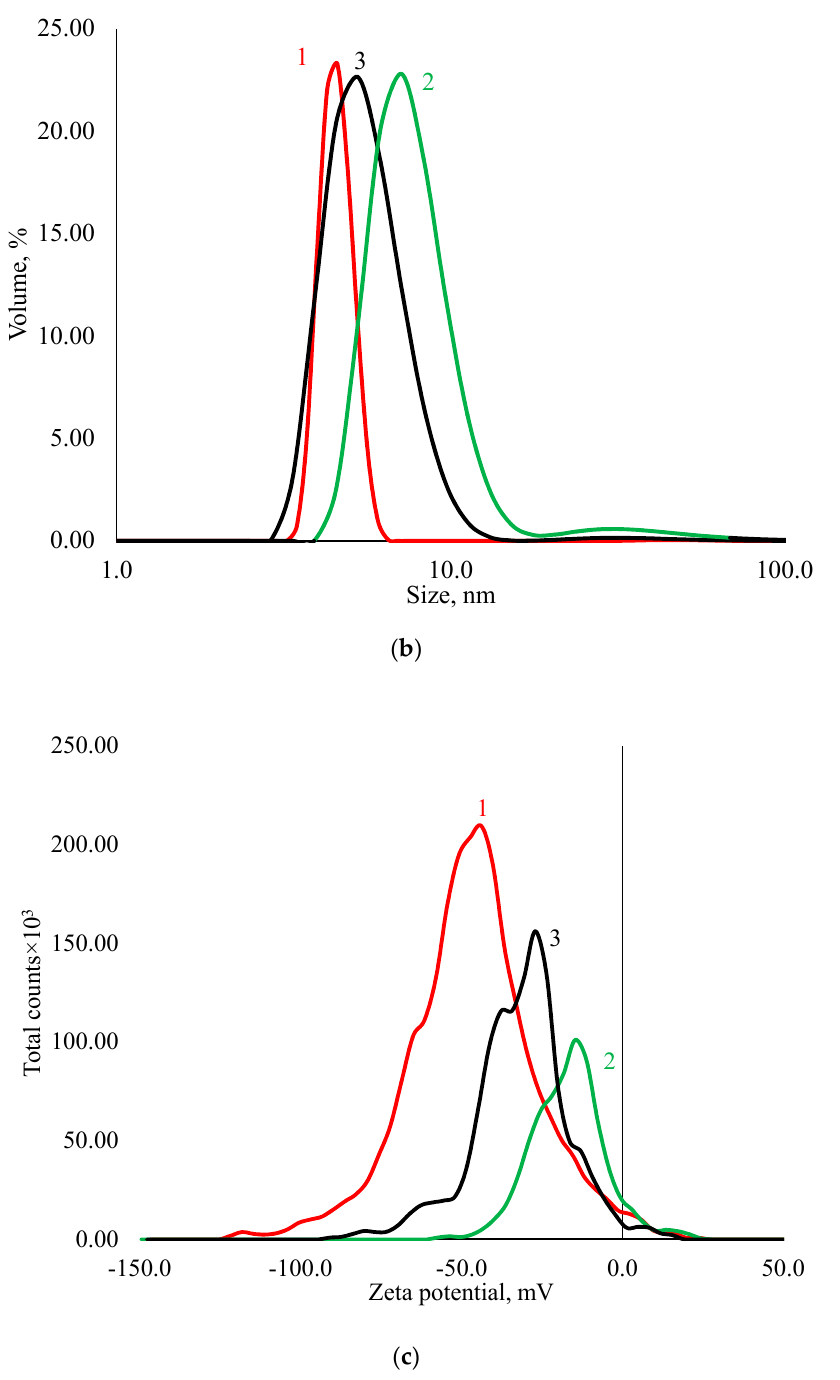
Figure 1. Physicochemical characteristics of AgNPs (1, initial suspension; 2, albumin ‐ coated silver nanoparticles; 3, poly ‐ sorbate ‐ 80 ‐ coated silver nanoparticles). ( a ) Cumulative particle concentration. ( b ) Size distribution of AgNPs by volume. ( c ) Zeta potential distribution.